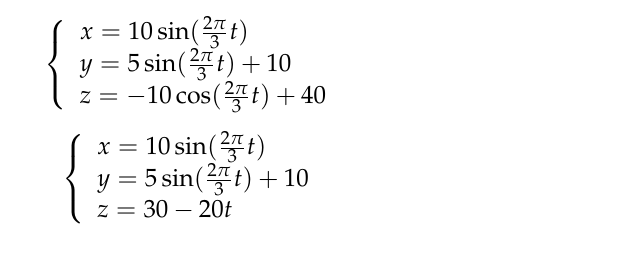
Figure 6. The integrated system.